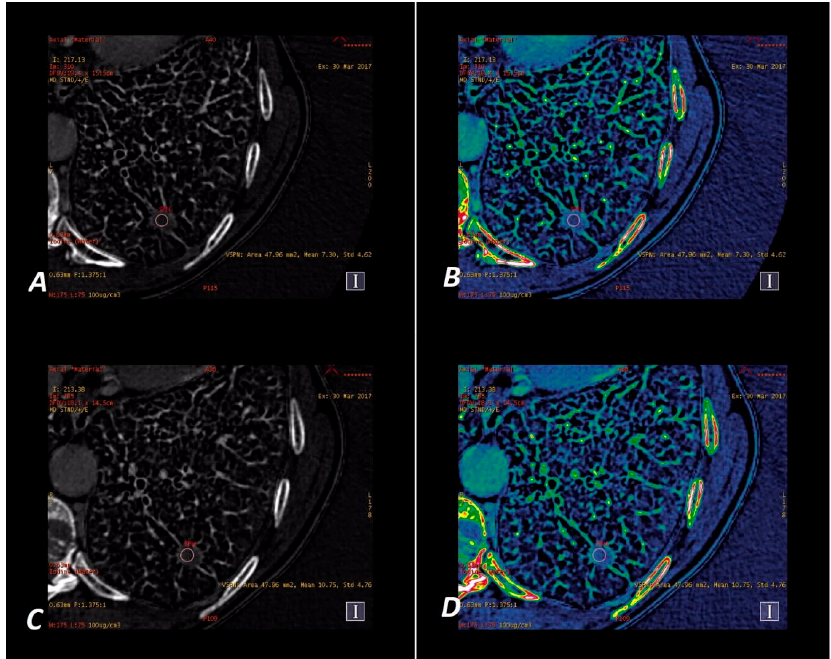
Figure 5. A 60-year-old man with tuberculoma. Iodine–based SS DECT images in AP ( A , B ) and VP ( C , D ). Iodine material density ssDECT image shows the iodine content in the region that shows hyperattenuation in SPN on Figure 3a,c. Colormap “French” ( B , D ) helps to identify the tumor compared to their standard presentation in “Linear Gray” ( A , C ). Iodine concentration mean = 7.30 × 100 µg/cm 3 (AP) and 10.75 × 100 µg/cm 3 (VP).